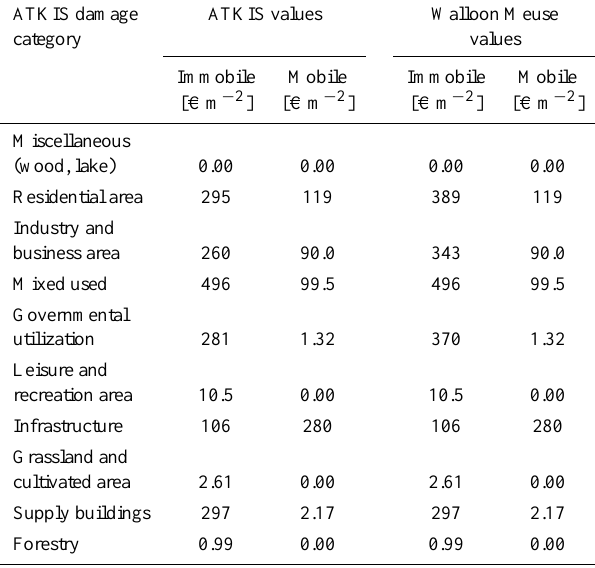
Table 3. Specific prices used for the damage